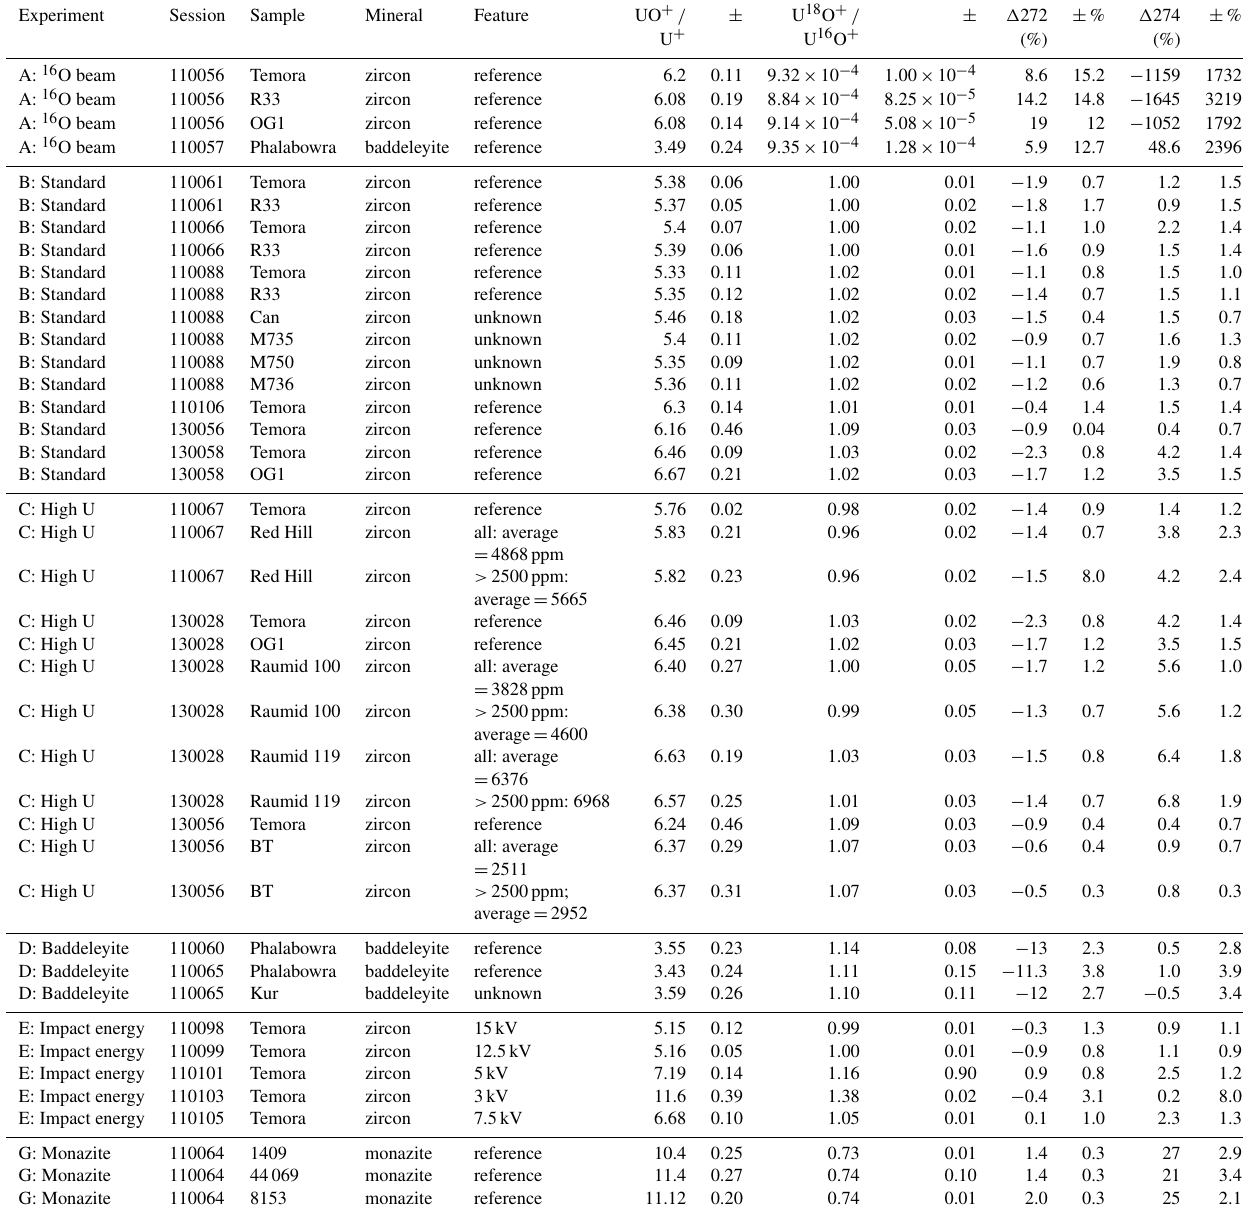
Table 1. Summary of isotopologue deviations for analytical sessions.